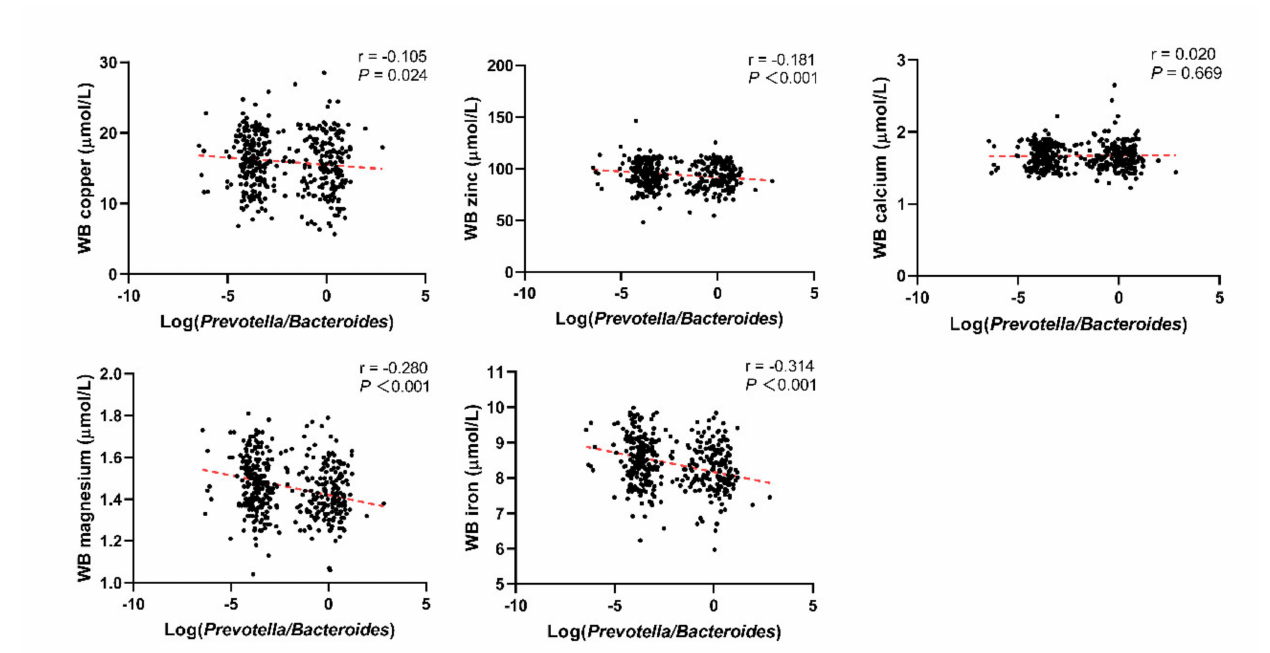
Figure 3. Correlation between Log( P/B ) and whole blood copper, zinc, calcium, magnesium, and iron levels among infertile group. Log( P/B ), Log-normalized Prevotella-to-Bacteroides; WB, whole blood.